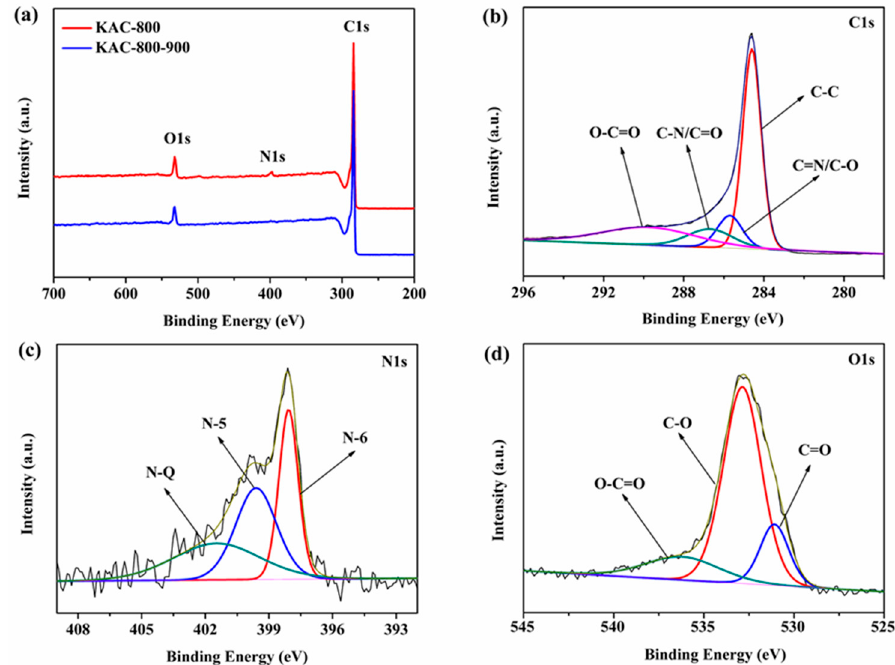
Figure 7. ( a ) XPS survey spectra of KAC-800 and KAC-800-900; ( b ) C1s spectrum of KAC-800; ( c ) N1s spectrum of KAC-800; ( d ) O1s spectrum of KAC-800.